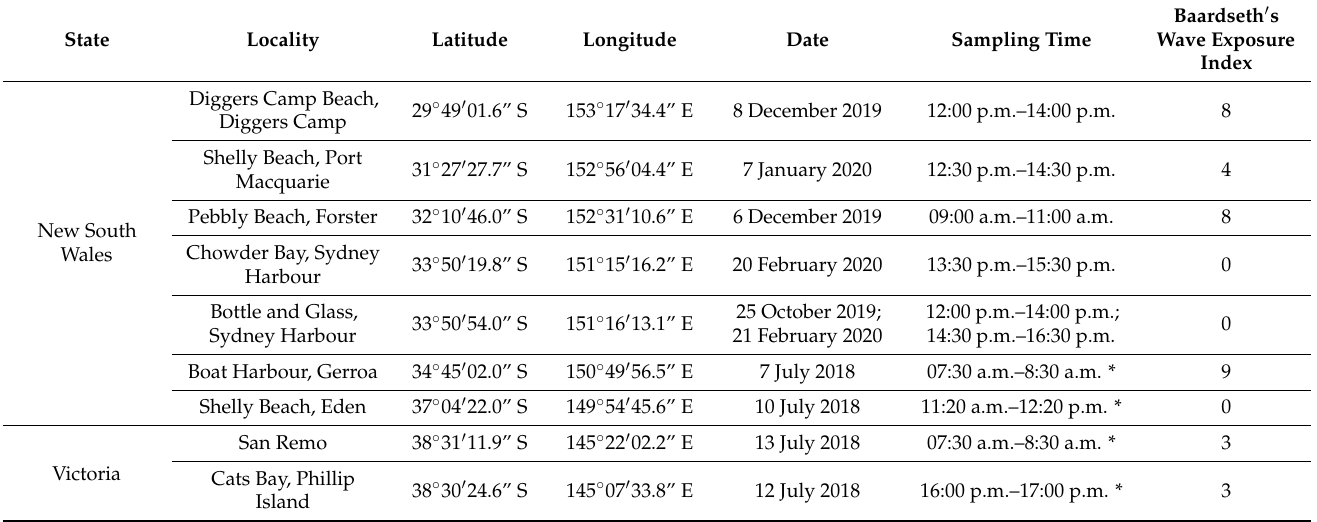
Table 2. List of sites and sampling times.